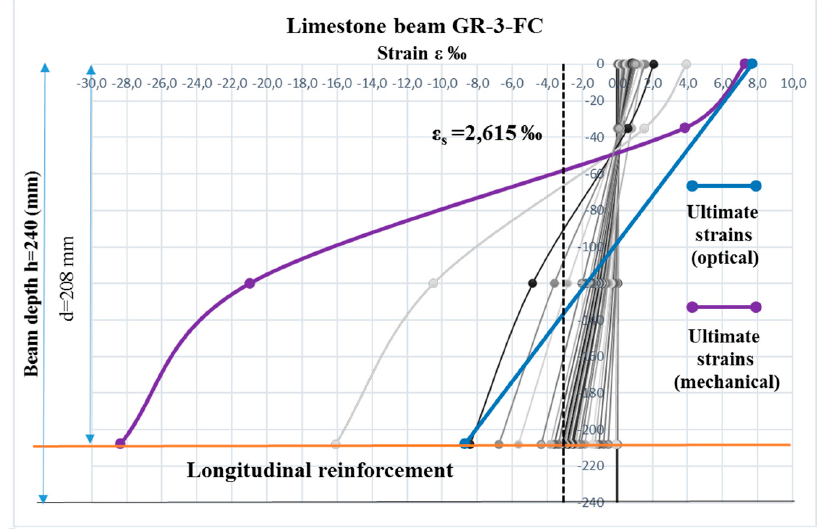
Figure 9. Experimental strains distribution at mid-span section according to mechanical and optical methods for limestone beam (GR-3-FC).